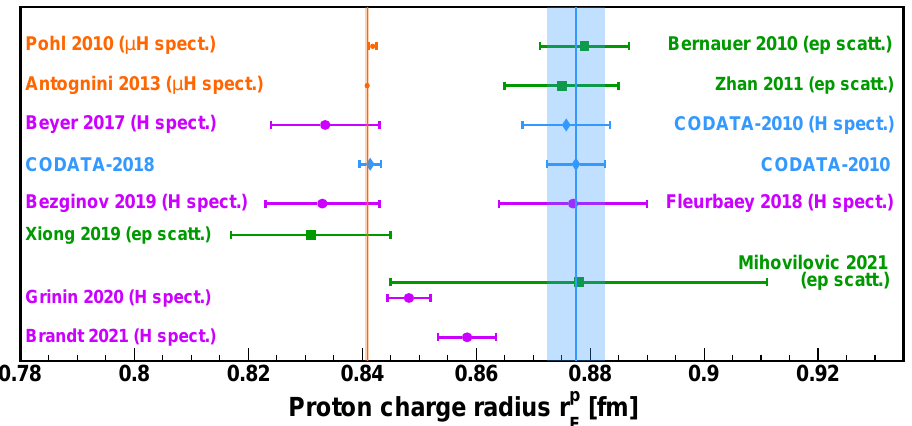
Figure 1. The proton charge radius determined from ep elastic scattering, hydrogen spectroscopic experiments, as well as world-data compilation from CODATA since 2010. The muonic spectroscopic measurements [19,20] are shown in orange dots, ordinary hydrogen spectroscopic results [12–16] are shown in purple dots, electron scattering measurements [2–4,6] are shown in green squares, and blue diamonds show the CODATA compilations